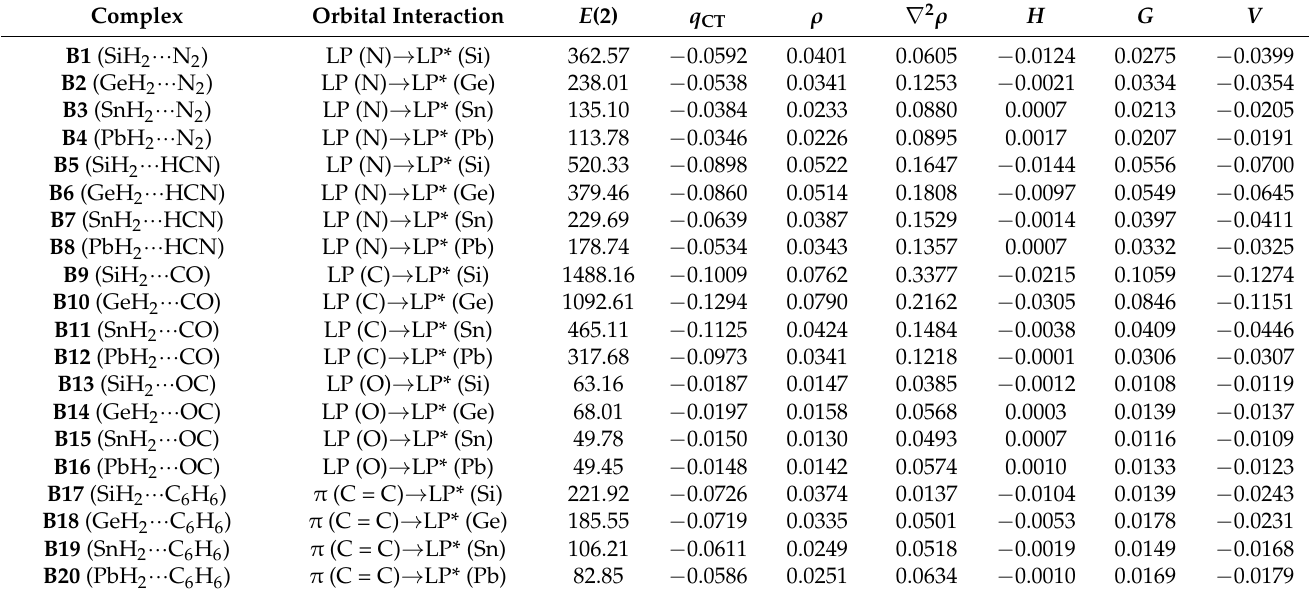
Table 5. Second-order perturbation stabilization energy ( E (2), in kJ/mol), charge transfer ( q CT , in e), electron density ( ρ , in a.u.), Laplacian ( ∇ 2 ρ , in a.u.), energy density ( H , in a.u.), local kinetic energy density ( G , in a.u.) and potential energy density ( V , in a.u.) at the BCP for type-B complexes.